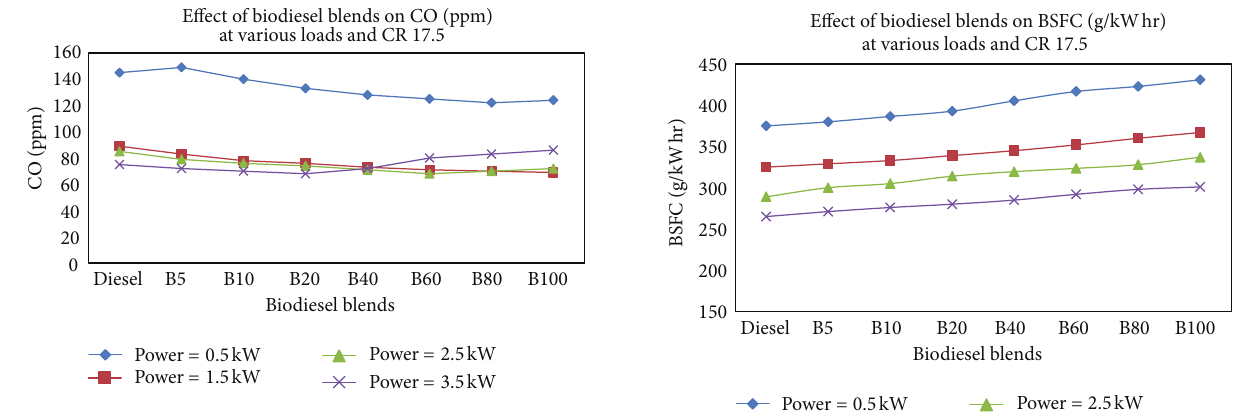
Figure 4: Variation in CO for various biodiesel blends at different loads.